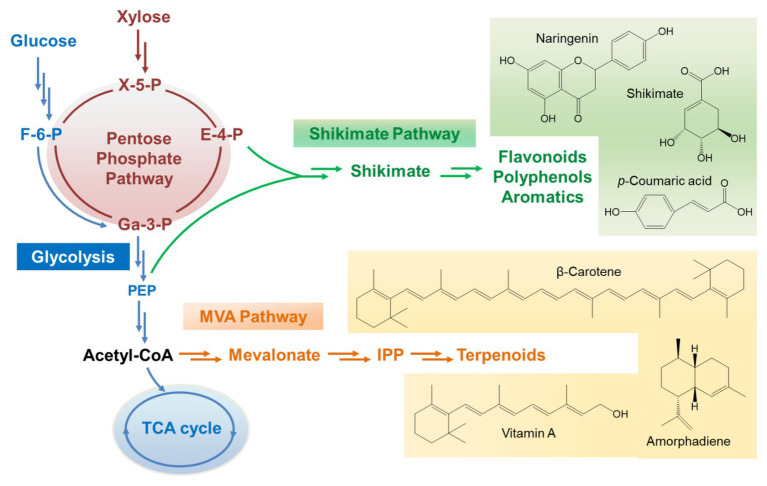
The metabolic flux channel to direct the production of natural products through the shikimate pathway and mevalonate pathway when xylose is employed as the carbon source. X-5-P, xylulose-5-phosphate; E-4-P, erythrose-4-phosphate; F-6-P, fructose-6-phosphate; Ga-3-P, glyceraldehyde-3-phosphate; PEP, phosphoenolpyruvate; IPP, isopentenyl diphosphate.